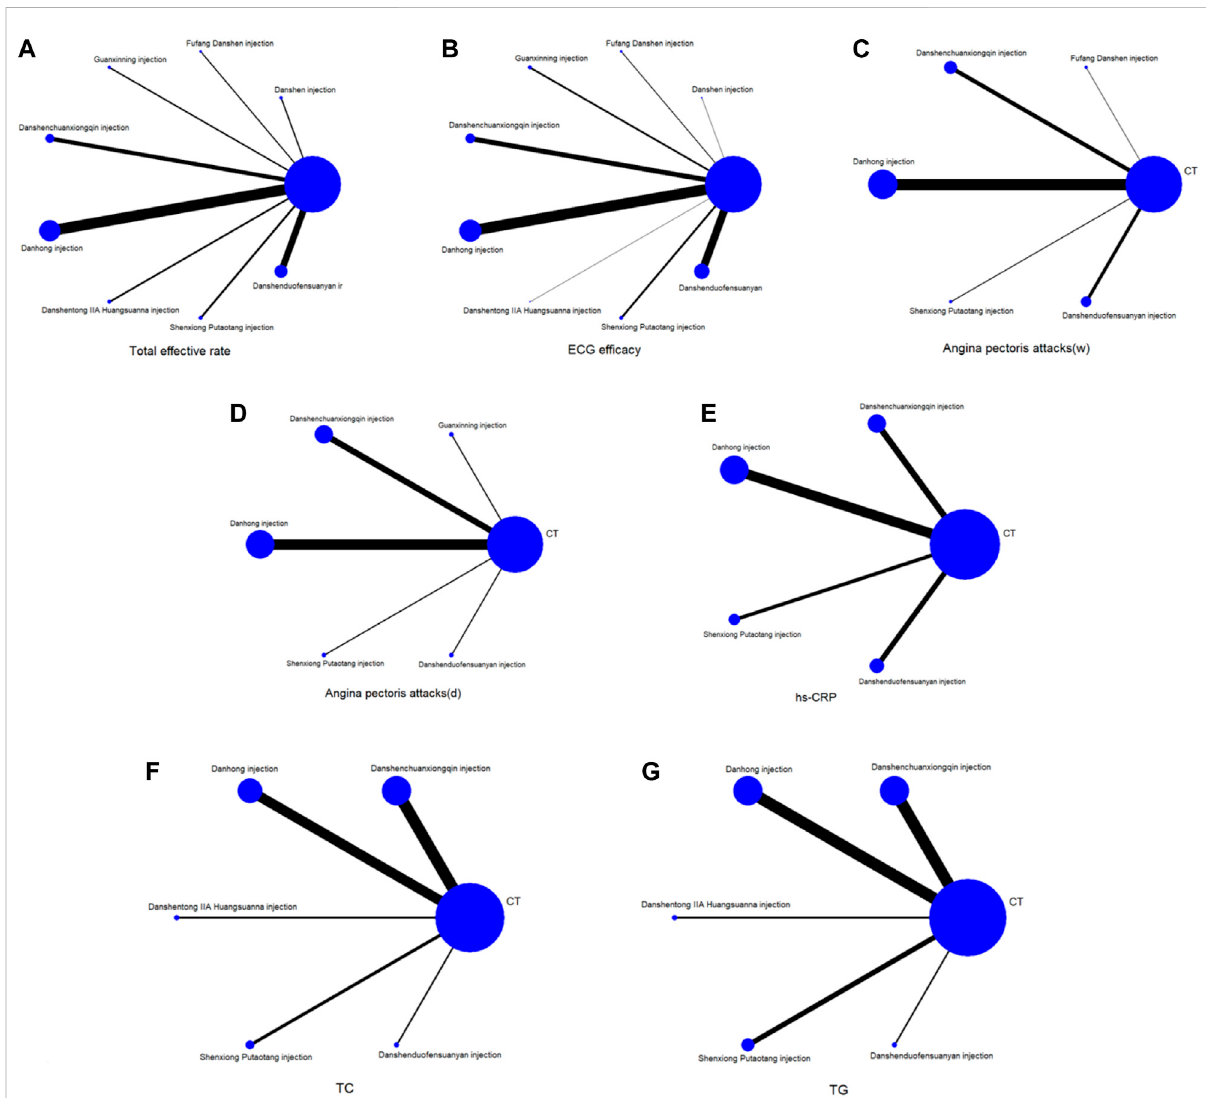
FIGURE 4 Network diagrams of comparisons on different outcomes of treatments in different groups of patients with UA. (A) total effective rate; (B) ECG ef fi cacy; (C) Angina pectoris attacks (weeks); (D) Angina pectoris attacks (days); (E) hs-CRP; (F) TC; (G) TG.